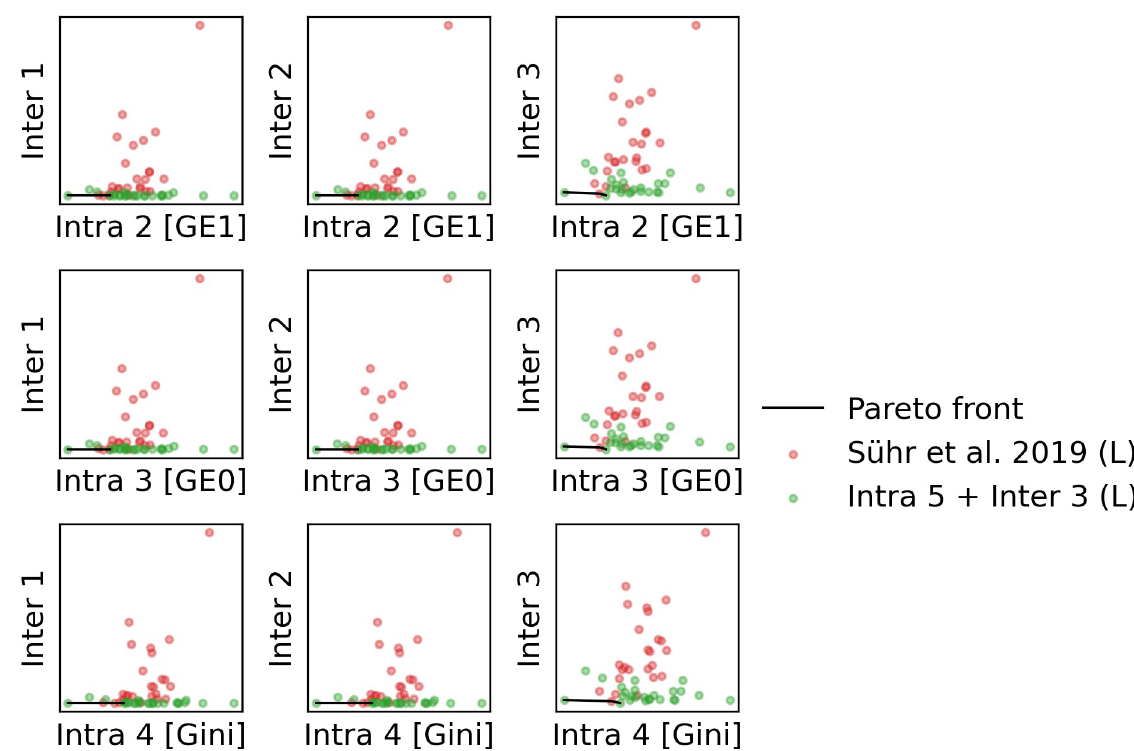
Fig 2. An illustration of the trade-off between Intra- and Inter-fairness in a single trial. The position of each dot represents the value of Intra- and Inter-fairness from one experiment using the implementation of the augmented Lagrangian formulation (10) in tssos . Red dots suggest the use of γ (1) = 1, γ (2) = 0, as in [11]. Green dots suggest the use of Intra 5 + Inter 3 (L). The Pareto front is shown by a black curve. See the Section of Supporting information for further